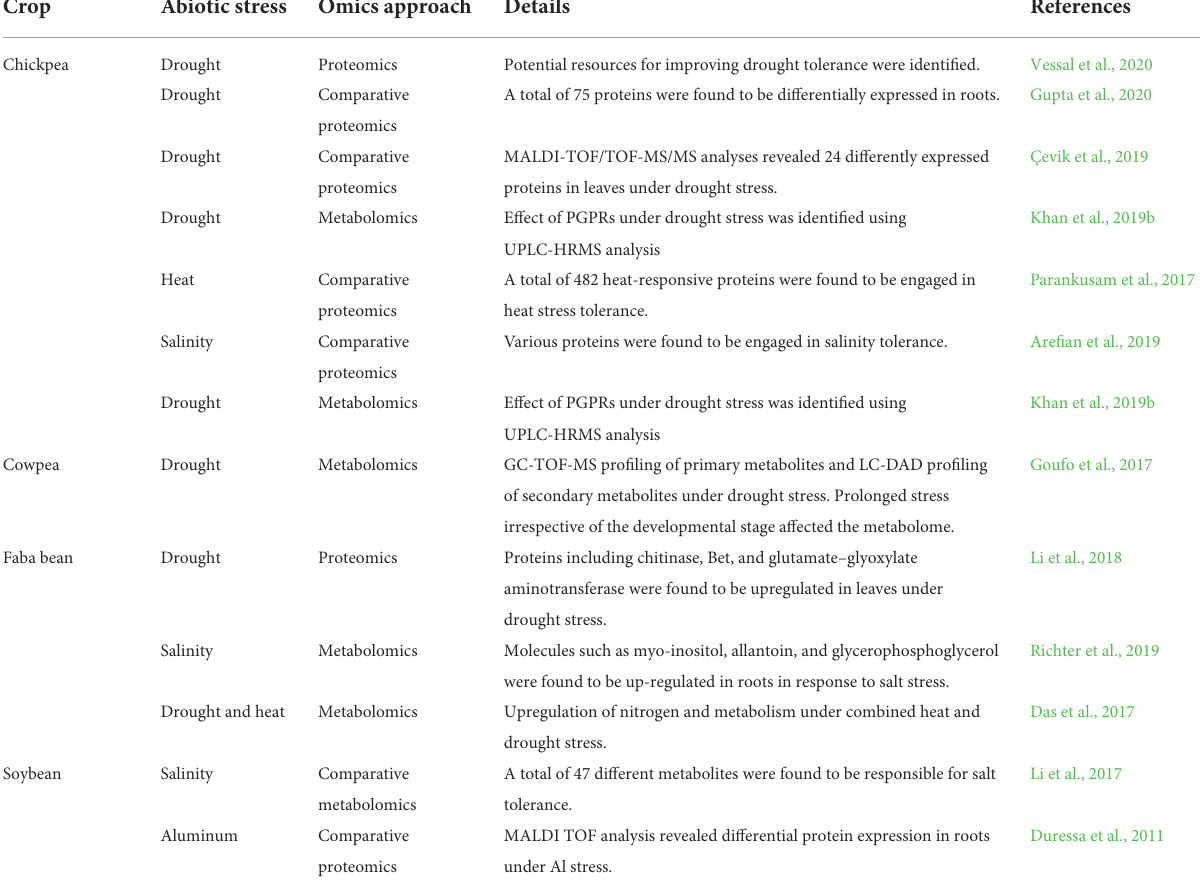
TABLE 8 Combating abiotic stresses in legumes using proteomics and metabolomics